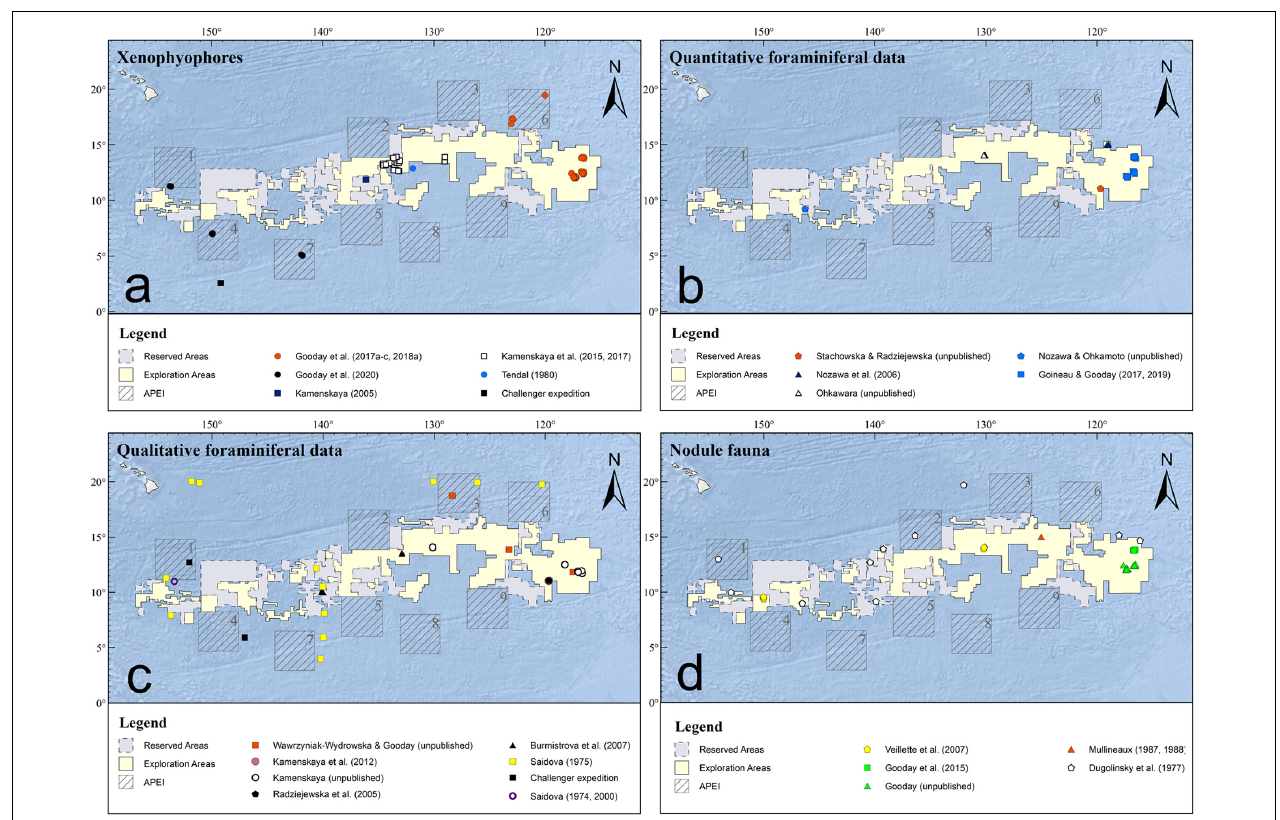
FIGURE 2 | Location of study sites within and in the vicinity of the Clarion-Clipperton Zone. (a) Xenophyophores. (b) Quantitative studies. (c) Qualitative studies. (d) Nodule-attached